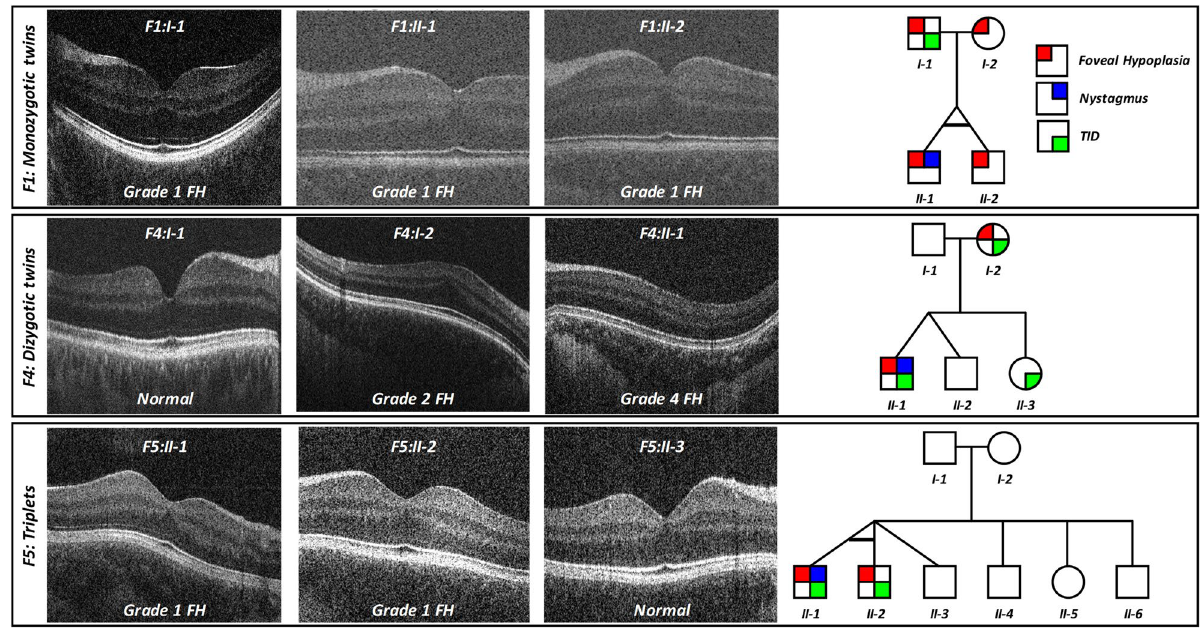
Figure 3. Optical coherence tomography. Spectrum of foveal development in nystagmus families. In family F1, all members had grade 1 foveal hypoplasia (FH). This is characterised by a shallow foveal pit, continuation of the inner retinal layers posterior to the foveola but a well developed outer retina. In family F4, we observe grade 2 FH in the mother (F4:I-2). This is characterised by a lack of the foveal pit but with some features of cone specialisation preserved. The proband (F4:II-1) had grade 4 FH, which has no features of foveal specialisation and resembles peripheral retina. In family F5 (triplets), the monozygotic twins in this family had grade 1 FH.